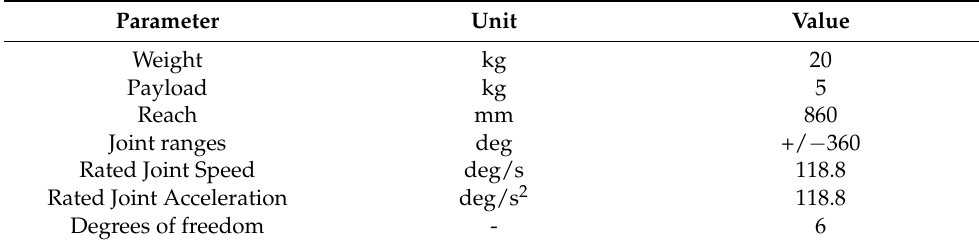
Figure 1. Conceptual diagram of joints and links of the target articulated robot. Table 1. Robot Design